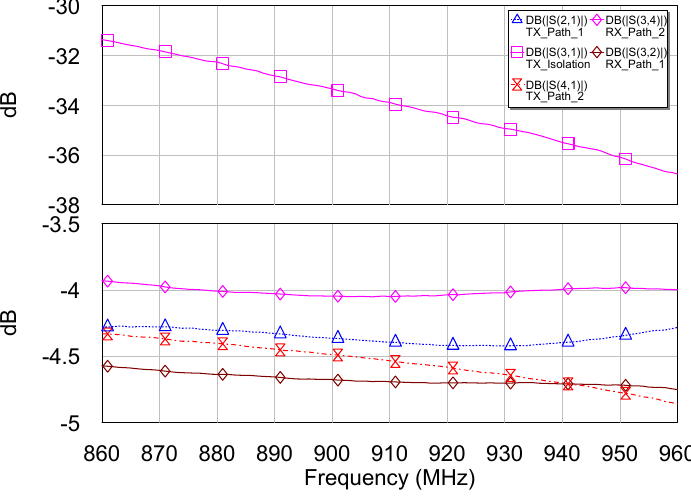
Figure 8. Simulated